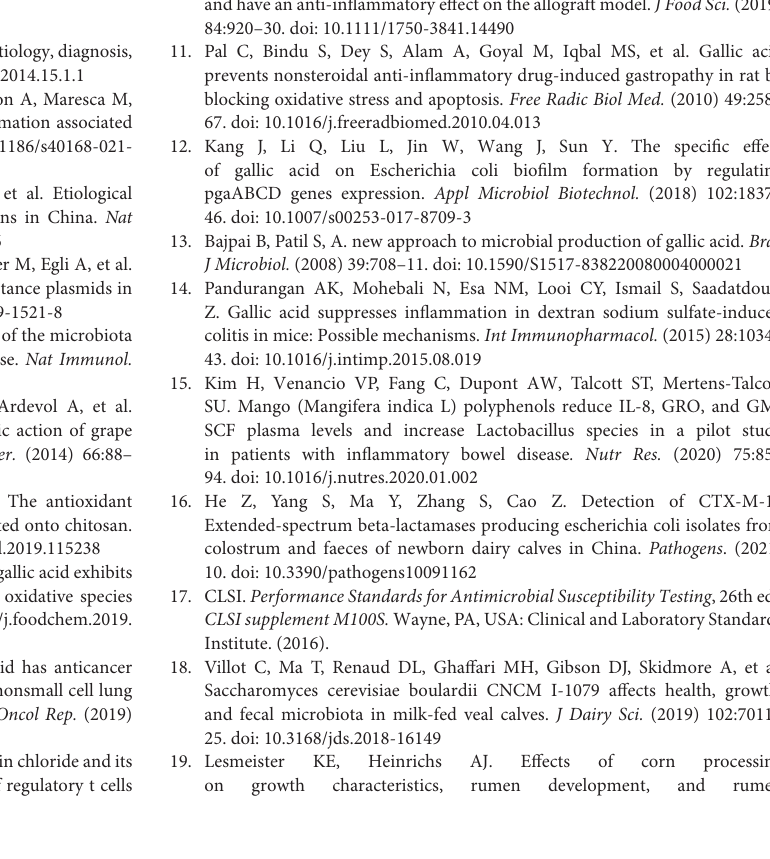
Supplementary Table 1 | Genomic analysis of DEC bacterial strain. Supplementary Table 2 | Sampling information of calves used in the current